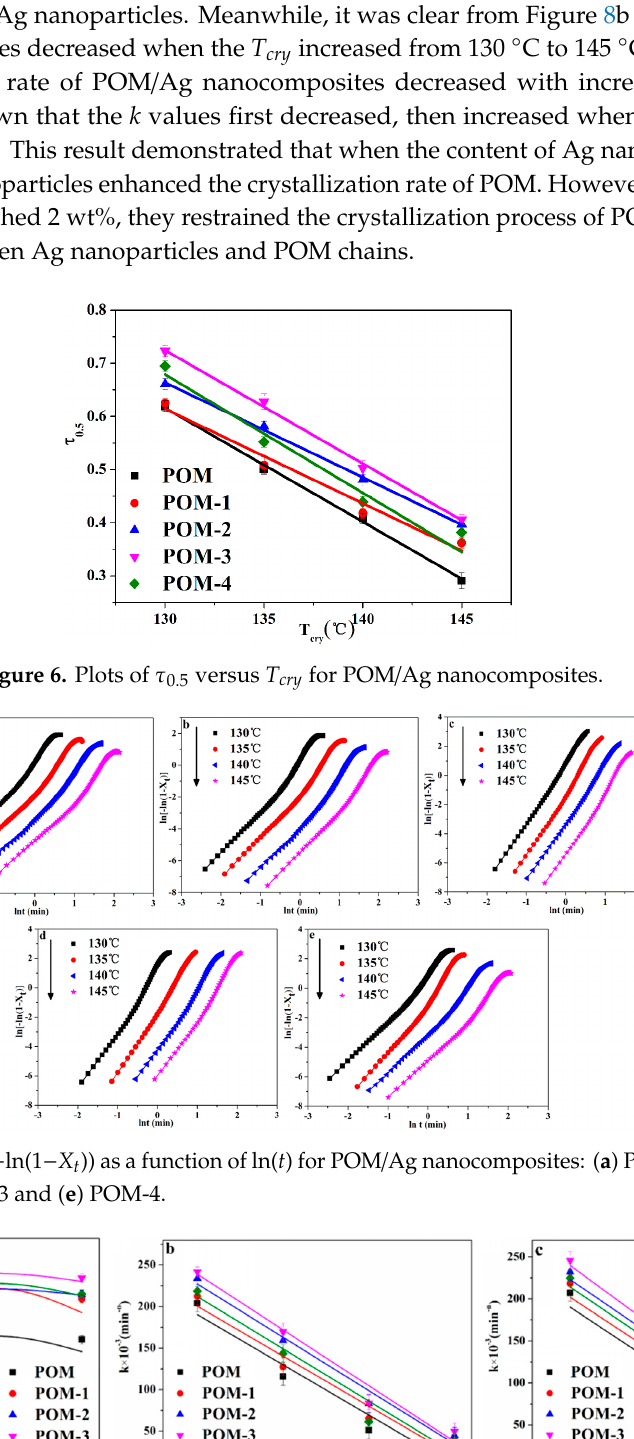
Figure 8. ( a ) Avrami exponent ( n ), ( b ) experimental Avrami rate constant ( k ), and ( c ) theoretical